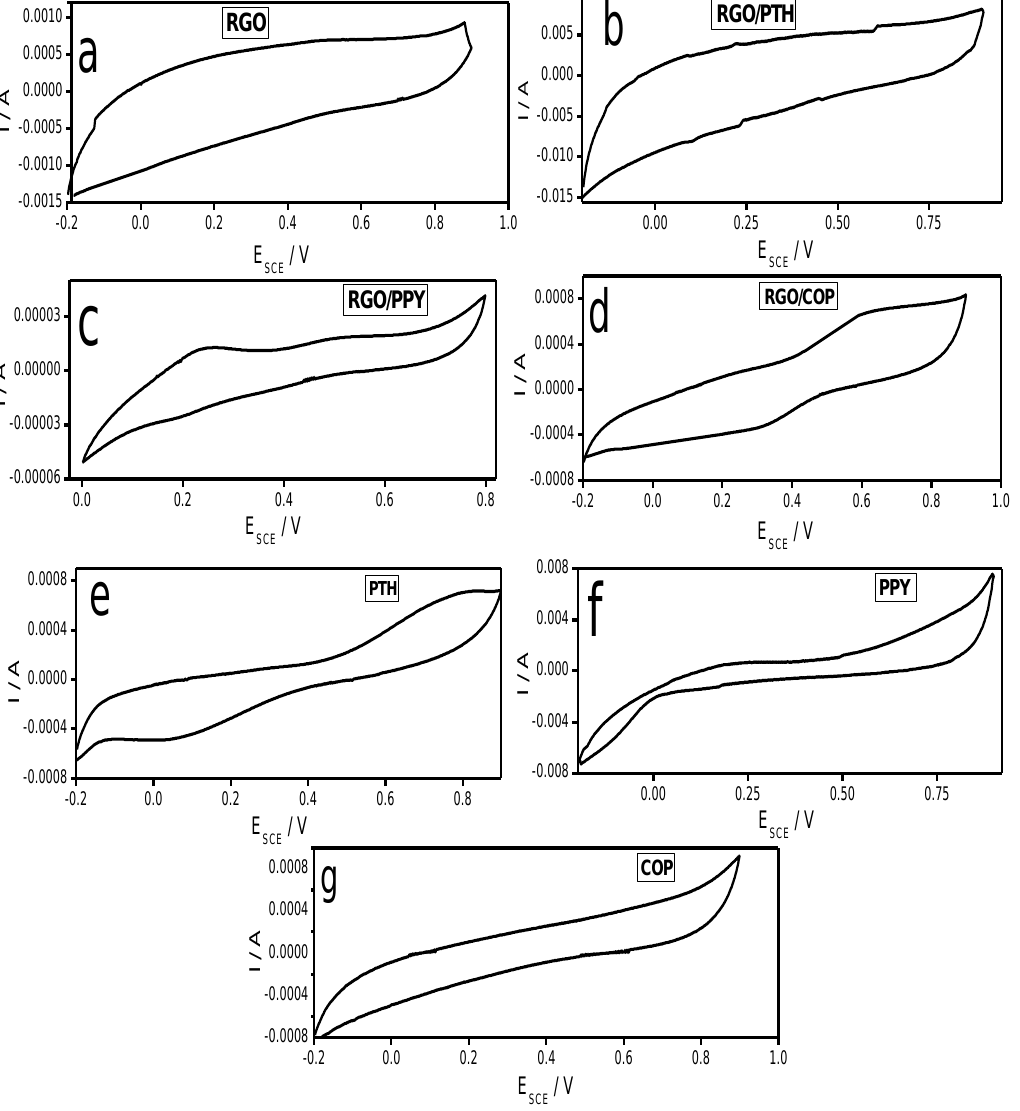
Figure 7. Cyclic voltammetry (CV) curves of ( a ) RGO, ( b ) RGO/PTH, ( c ) RGO/PPY, ( d ) RGO/COP, ( e ) PTH, ( f ) PPY, and ( g ) COP at 10 mV/s.